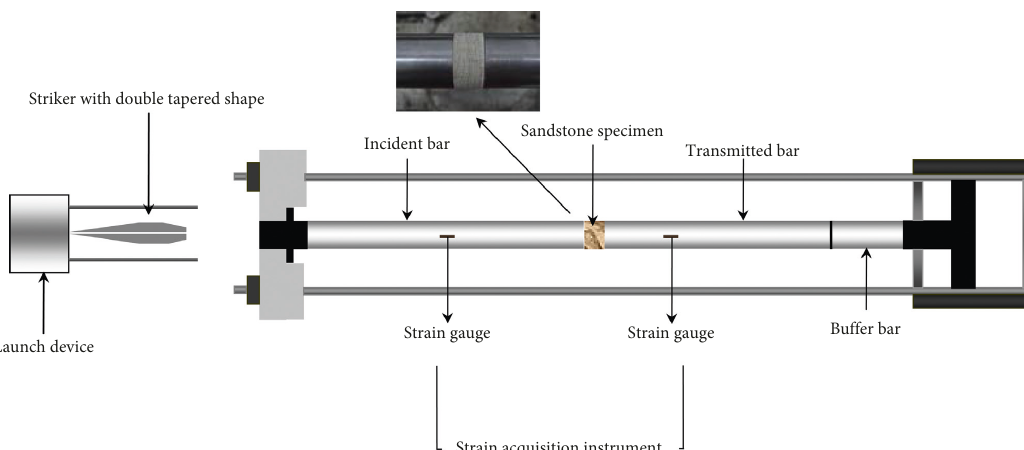
Figure 4: The functional diagram of